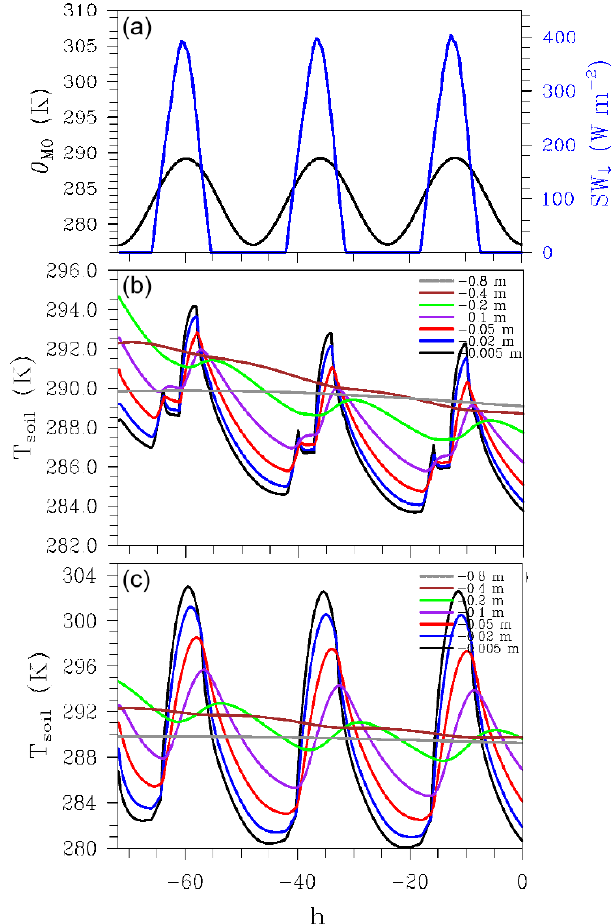
Figure 3. Time series during an exemplary surface spinup of 3d (72h) starting on 3 March for a small LES setup, including differ- ent surface types and buildings, geographically located in Hannover, Germany. Panel (a) shows the surface forcing, imposed by an unob- structed incoming solar radiation and the subsequent near-surface potential temperature forcing, while panels (b) and (c) show the re- sulting material temperatures T soil for a soil covered by short grass and an asphalt pavement, respectively. The time axis denotes the hours until the start of the full 3-D atmospheric simulation. Note that the radiative forcing shown in panel (a) does not match the re- sults shown in panel (b) , where shadowing by buildings causes a drop in incoming shortwave radiation during afternoon